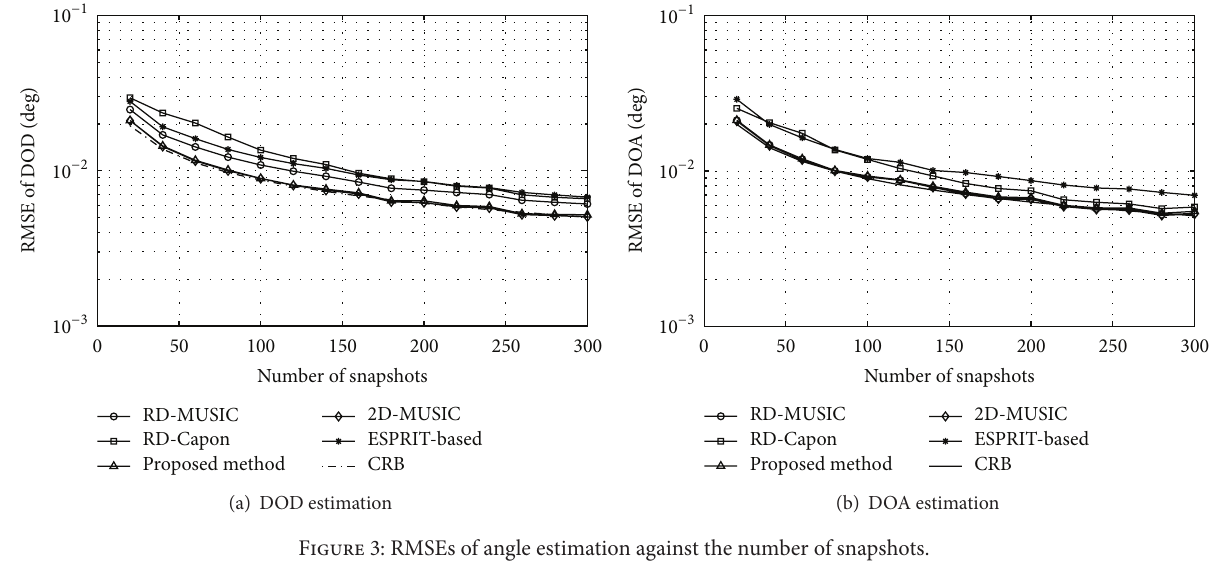
Figure 3: RMSEs of angle estimation against the number of snapshots.